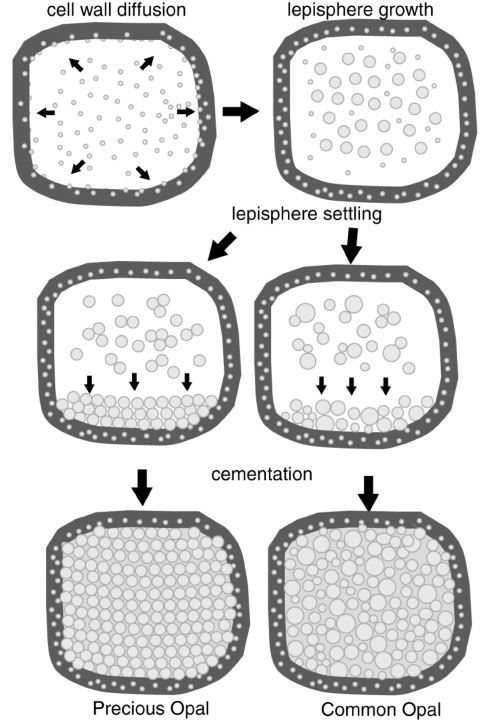
Figure 4. Silicification of a wood cell begins with hydrogen bonding of silicic acid monomers or small polymers to organic constituents in the cell wall. Silica in groundwater filling the cell interior (lumina) subsequently aggregates to lepispheres of varying size. These lepispheres settle by gravitation to the bottom of cell. Silica cement eventually fills interstitial spaces, producing solid opal. Depending on the degree of order in the stacked lepispheres, the final product may be either precious opal or common opal.